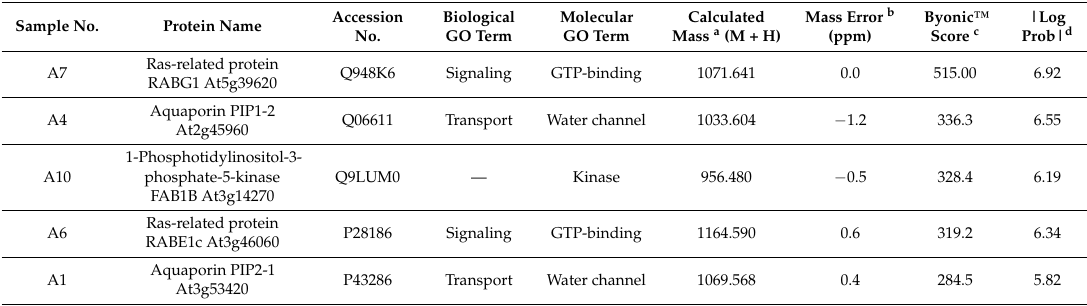
Table 4. LC-MS/MS identification of A. thaliana PM-associated candidate proteins interacting with ergosterol-hemisuccinate immobilized on EAH Sepharose 4B resin for the time study (Supplementary Data Sheet